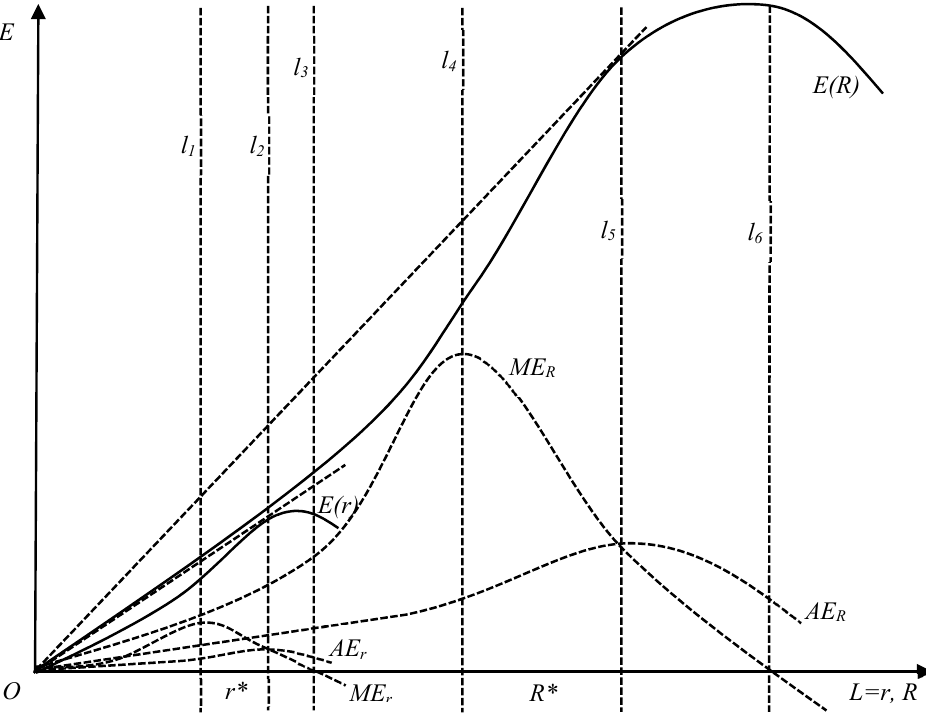
Figure 2. Schematic diagram of the construction land allocation in the CLR process. From the research: (1) The radius of transactions chosen by municipal and